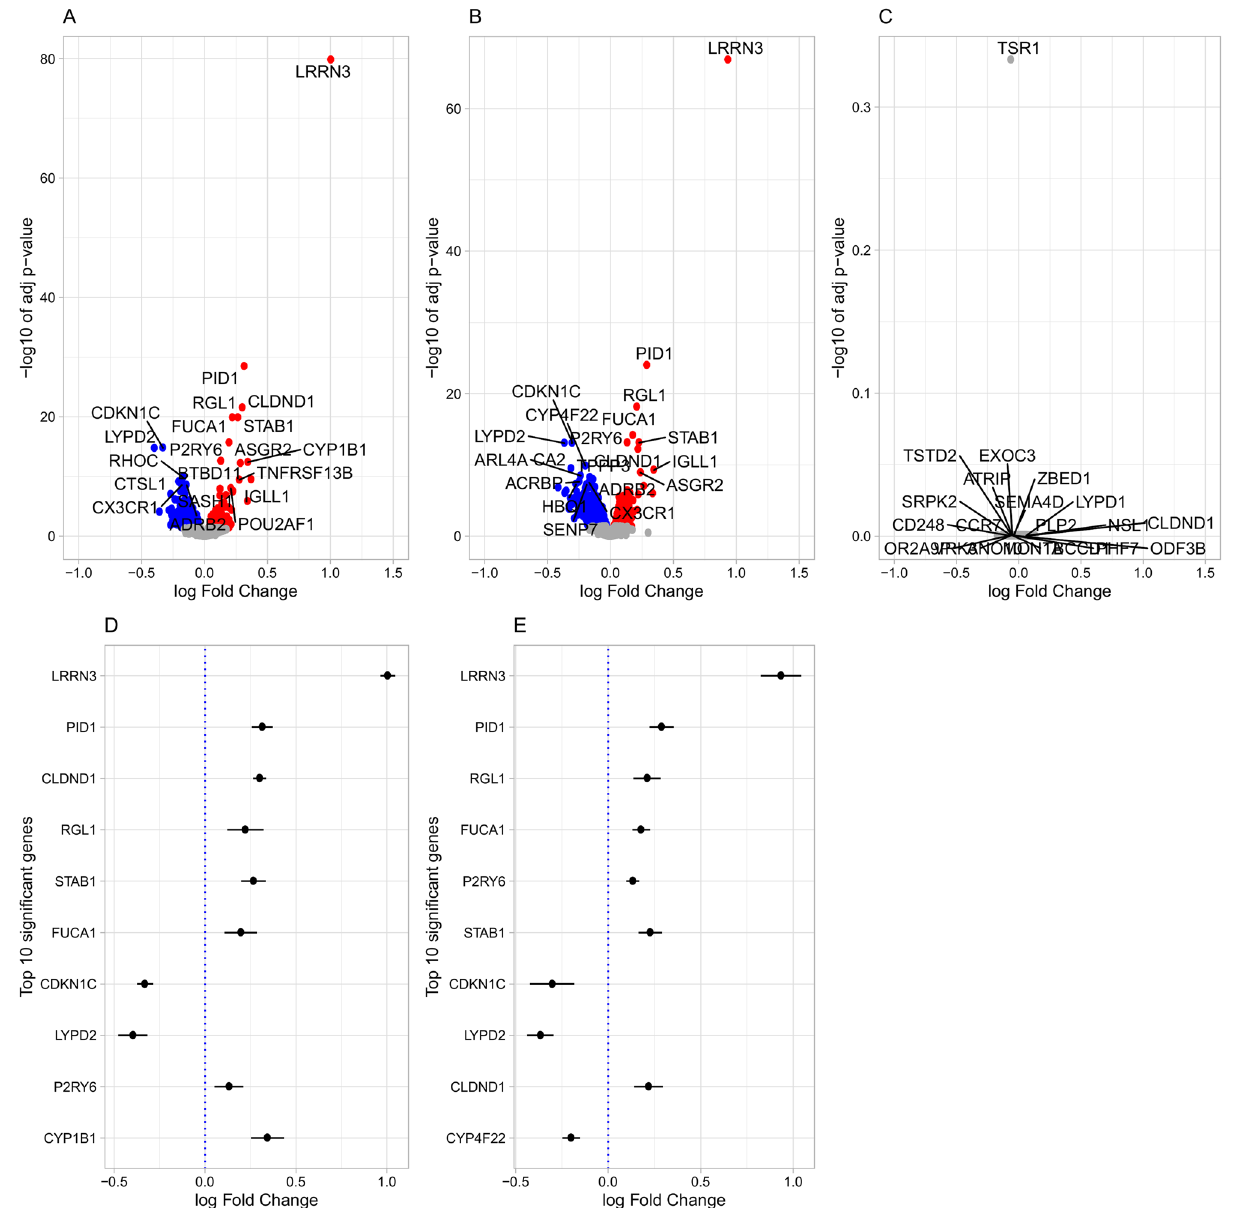
Figure 2. Volcano plots for the test statistics in fully-adjusted models from the tests of differentially expressed genes (DEGs) in comparisons of ( A ) current versus never smokers, ( B ) current versus former smokers, and ( C ) former versus never smokers; and forest plots for the 10 top-ranked DEGs in tests of DEGs in comparisons of ( D ) current versus never smokers and ( E ) current versus former smokers. In volcano plots ( A – C ), red dots display up-regulated genes, blue dots display down-regulated genes, while grey dots display genes with FDR > 0.05; the x-axis presents log 2 fold-changes and the y-axis presents − log10 of FDR adjusted p-values; and gene names displayed are the 20 top-ranked DEGs in the respective tests. In forest plots ( D and E ), dots in the x-axis represent log 2 fold-changes and the y-axis represents DEGS with the lowest FDR adjusted p -values ranked from the top; the horizontal line for each gene represents their confidence interval; and the vertical blue dotted line represents no